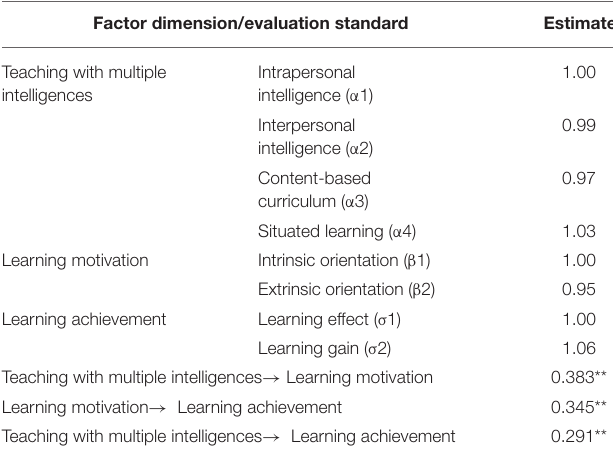
TABLE 1 | Overall linear structure model analysis